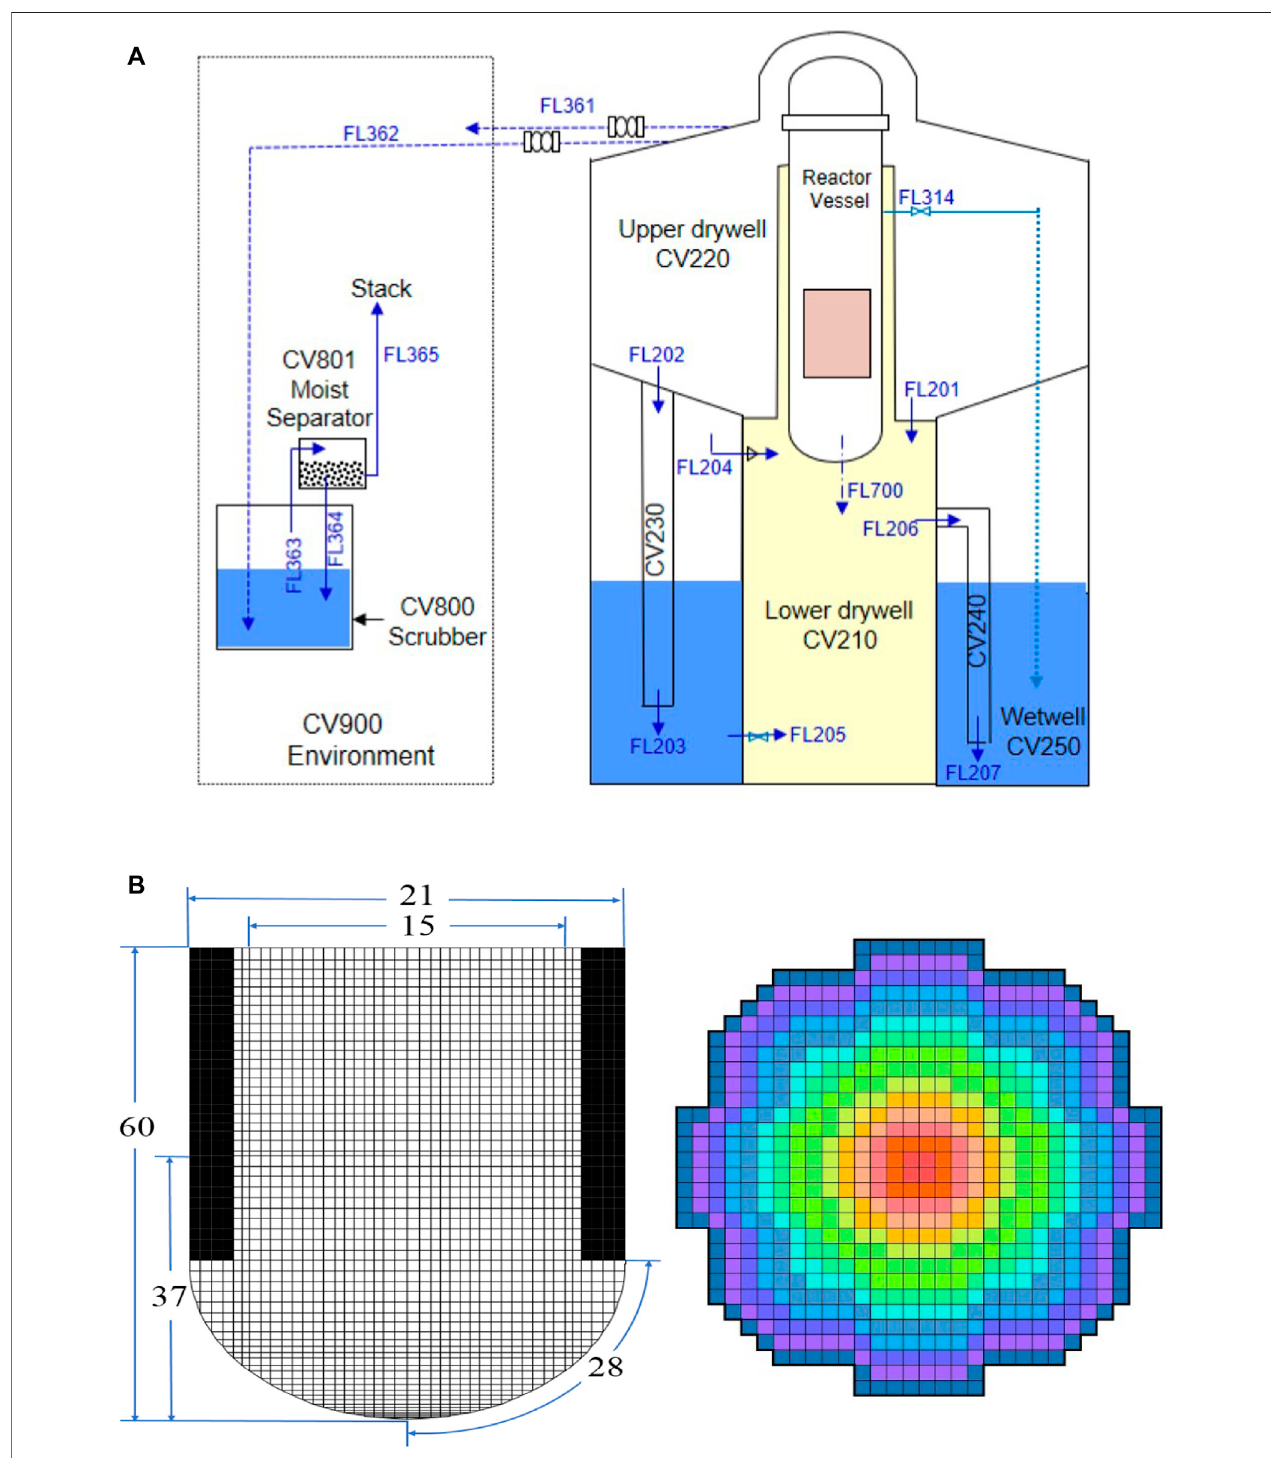
FIGURE 2 | (A) Schematic of the containment nodalization of a Nordic BWR, (B) fi ne nodalization in the COR package of MELCOR, and (C) group of fuel assemblies for radial rings (Chen et al., 2019).